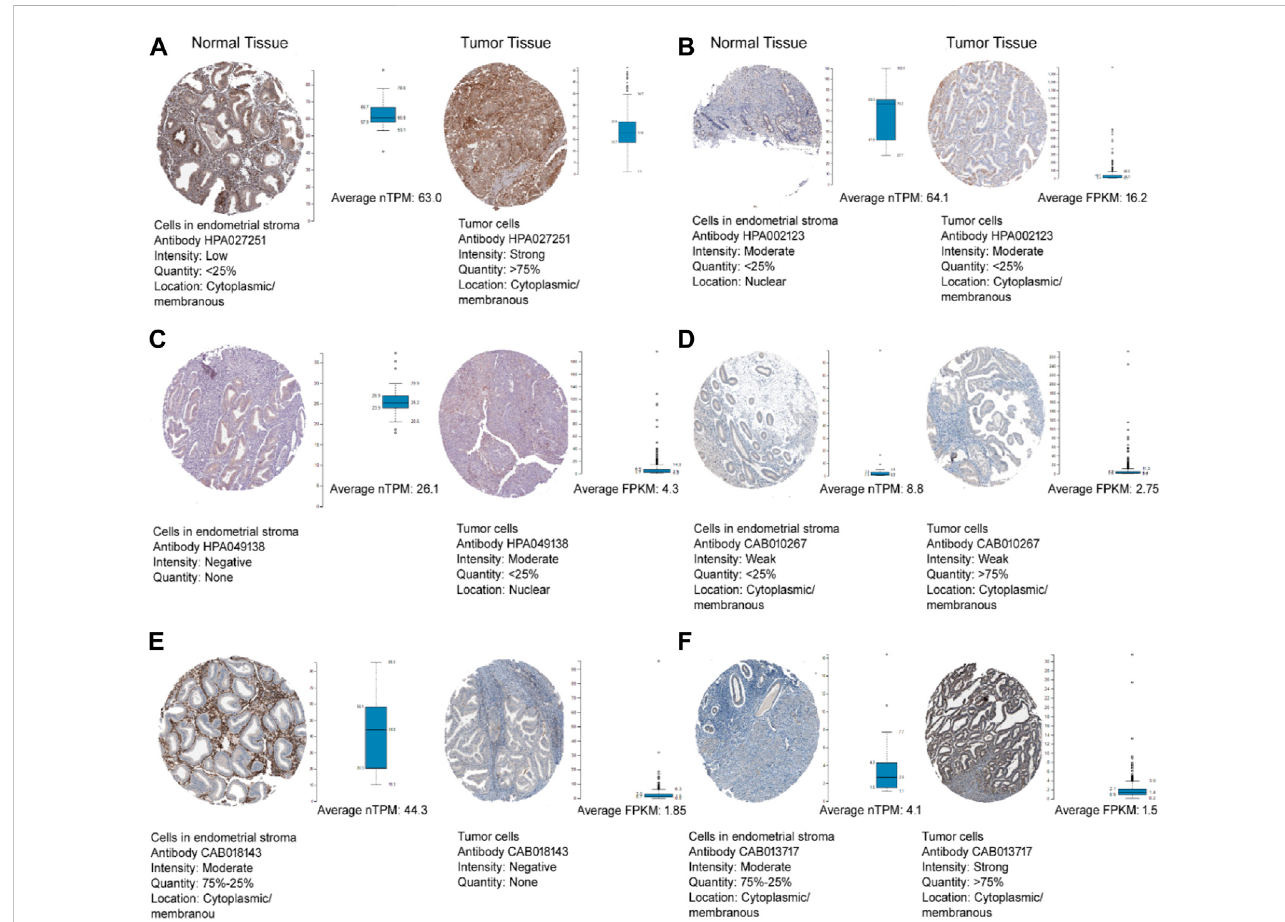
FIGURE 6 The Human Protein Atlas immunohistochemistry of hub genes in endometrial cancer and normal endometrial tissues (magni fi cation of 4X10) (A) ABL1 , (B) ALDH1A1 , (C) CCND2 , (D) FOSB , (E) PDGFRA , and (F) PTCH1 . Immunohistochemistry fi gure represented the antibody, staining intensity and subcellular localization. The whisker box plot determines the hub genes TPM and FPKM values in normal and tumour